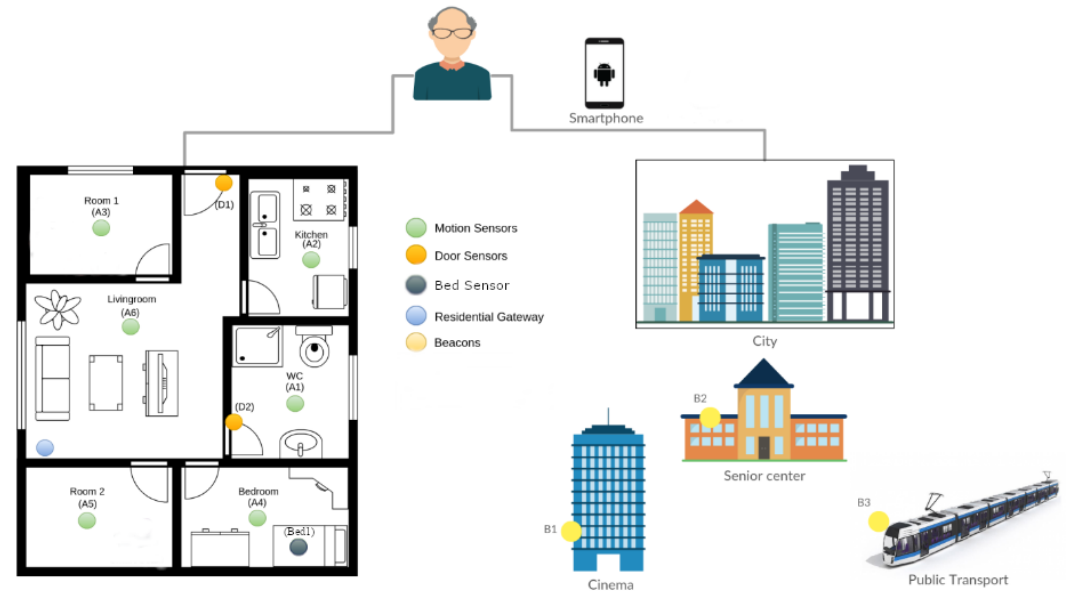
Figure 1. Montpelier pilot site global